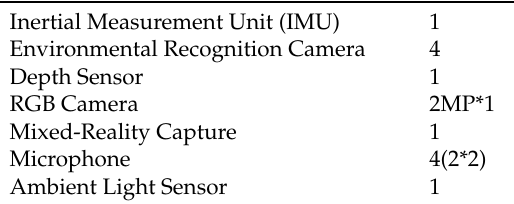
Table 2. Technical Specifications of the